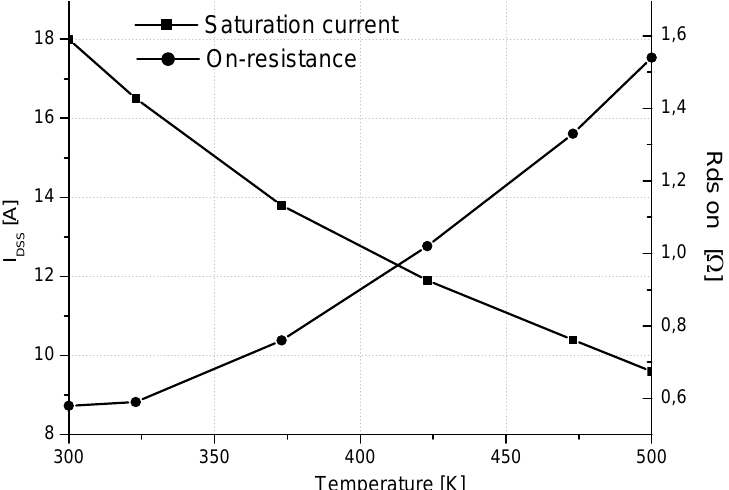
Figure 9. Experimental on-resistance and saturation current versus temperature of the 15 A-1,200 V SiC-JFET